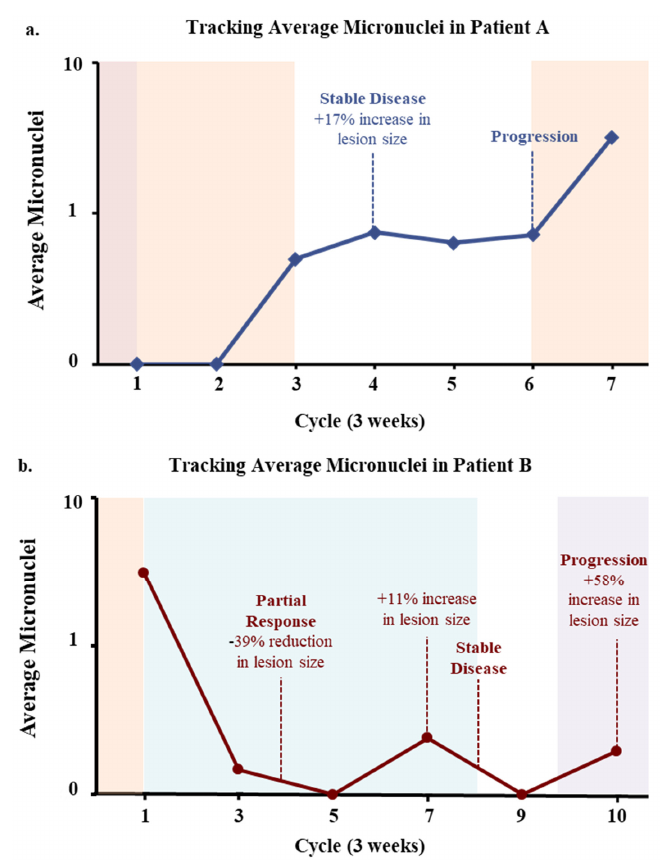
Figure 4. Case Studies Tracking Average Micronuclei in Subsequent Blood Draws. ( a ) Patient A. After progression on maintenance therapy (Xeloda, red), FOLFOX (orange) was started. MN were found to increase after 4 therapy cycles which correlated to an increase in tumor (+17%). Therapy was halted due to an infection. MN then increased further correlating with finding of new